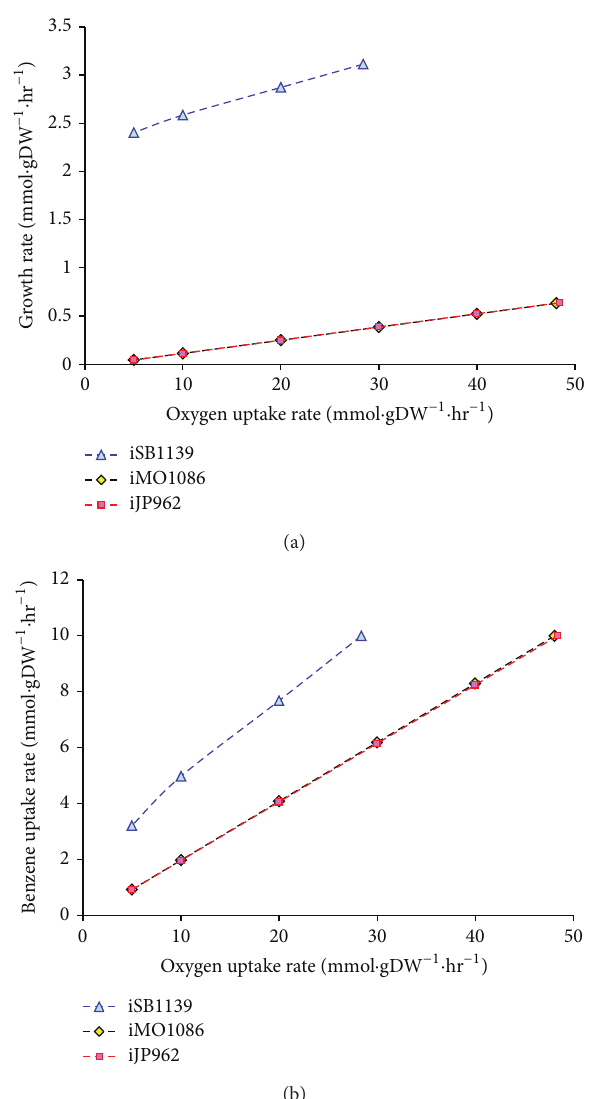
Figure 1: (a) In silico modeling of Pseudomonas species growth on benzoate under different oxygen regimes. In all three cases, biomass production increases as the oxygen uptake flux increases. The same pattern exists in all of the models. However, experimental data suggesteddifferenttrendsofresponsetotheavailableenvironmental oxygen. (b) Benzoate uptake flux under different oxygen regimes. Similartothegrowthrate,fluxoftheuptakereactionincreasesasthe available environmental oxygen concentration augments in contrast to the experimental